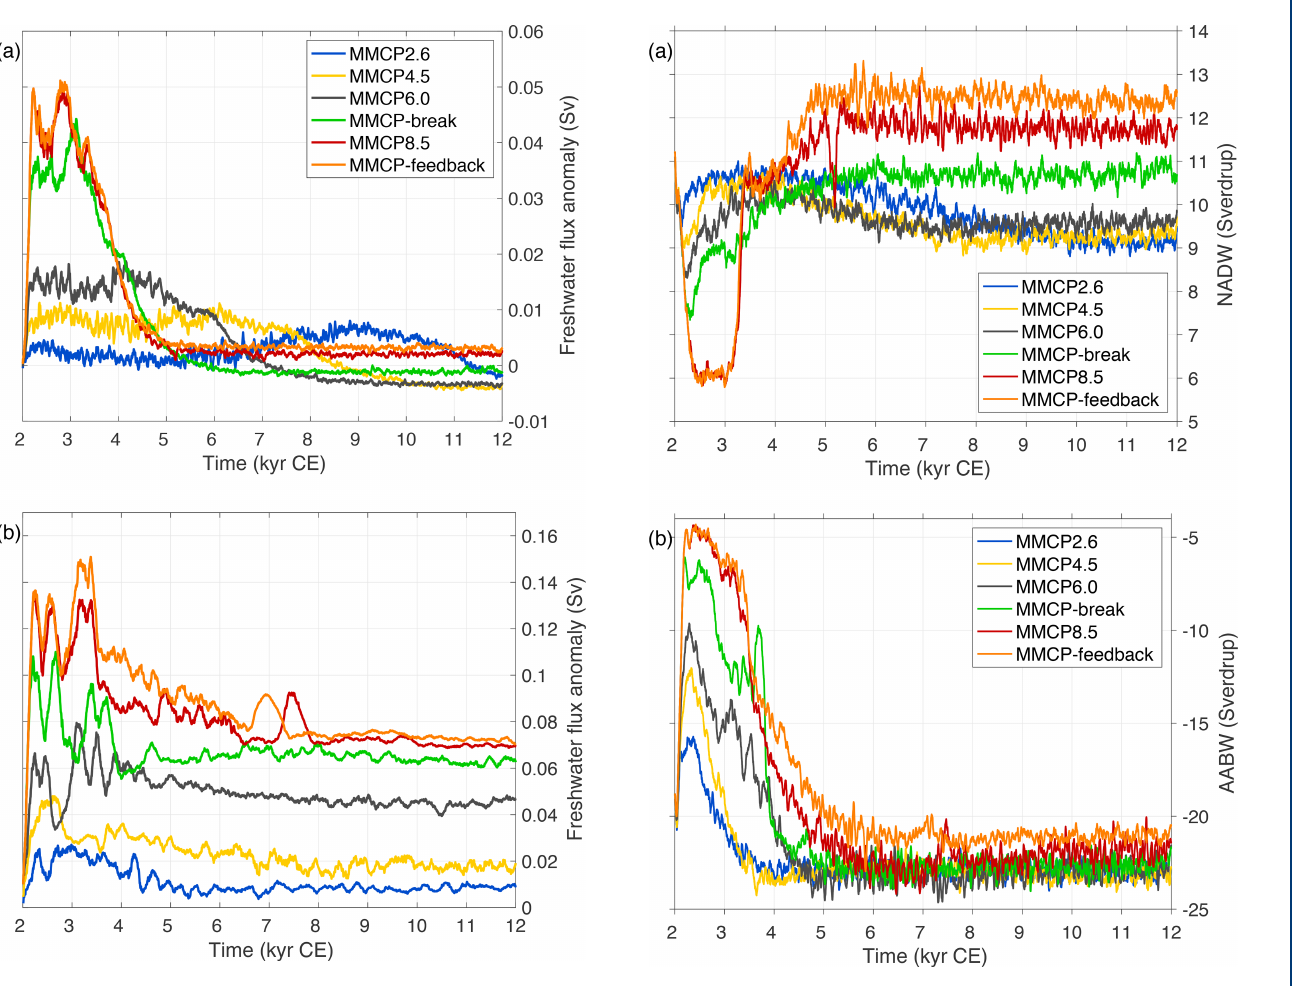
Figure 9. Mean annual strength of the North Atlantic Deepwater (NADW) (a) and the Antarctic Bottom Water (AABW) (b) forma- tion from 2000CE to 12000CE. AABW is defined as the maximum of the global meridional overturning streamfunction in the bottom cell and NADW as the maximum of the meridional overturning cir- culation in the Greenland, Iceland, and Norwegian